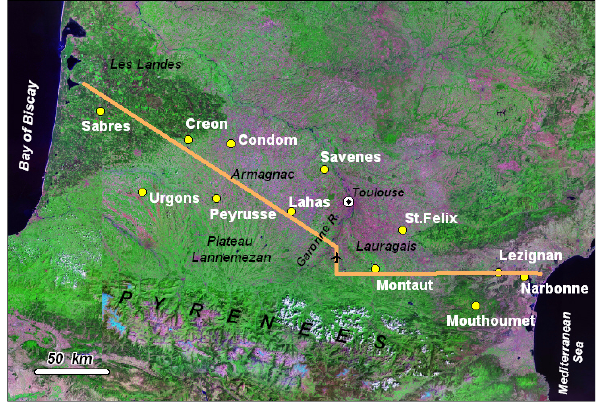
Fig. 1. Atlantic-Mediterranean transect and location of SMOSMA- NIA stations (background is a Landsat GeoCover